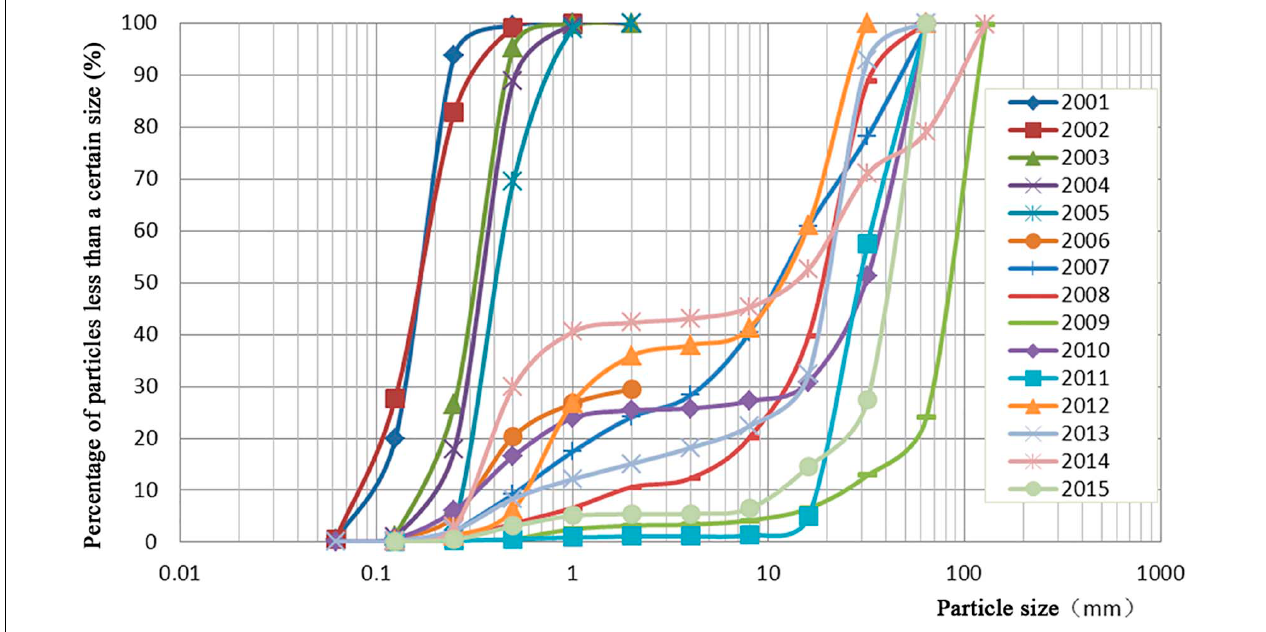
FIGURE 6 | Gradation curve of post-flood riverbed materials at Yichang station.